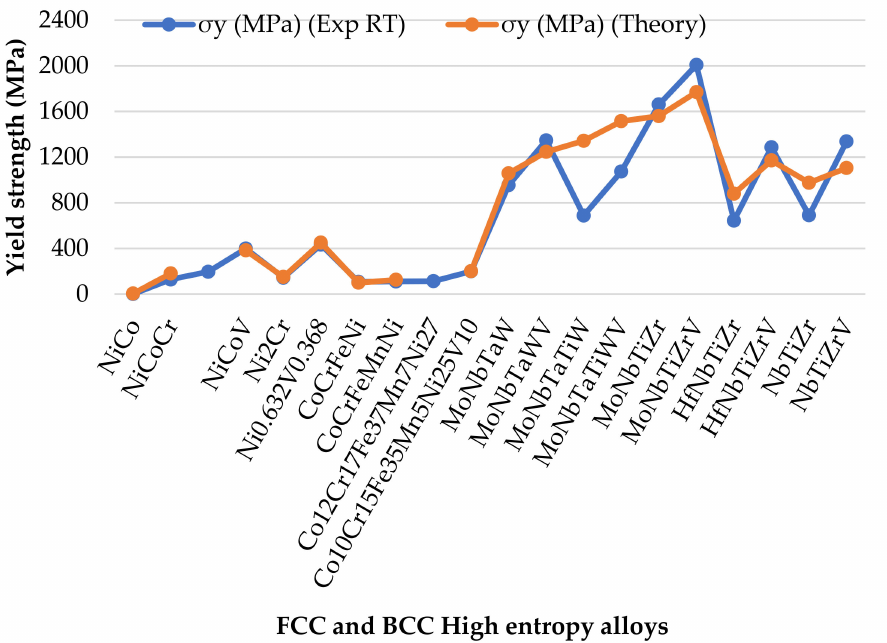
Figure 7. Yield strength ( σ y ) against types of HEAs/HESAs where experimental value at room temperature (RT) is compared with theoretical value (determined by Varvenne et al. [56] model). Data adapted from